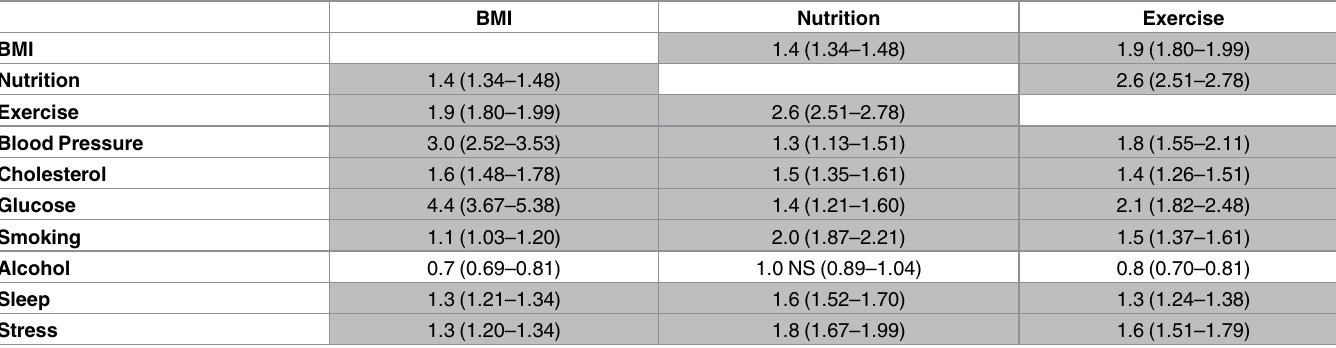
Table 5. Odds ratios–Likelihoods of not meeting different national guidelines based on risk category for other